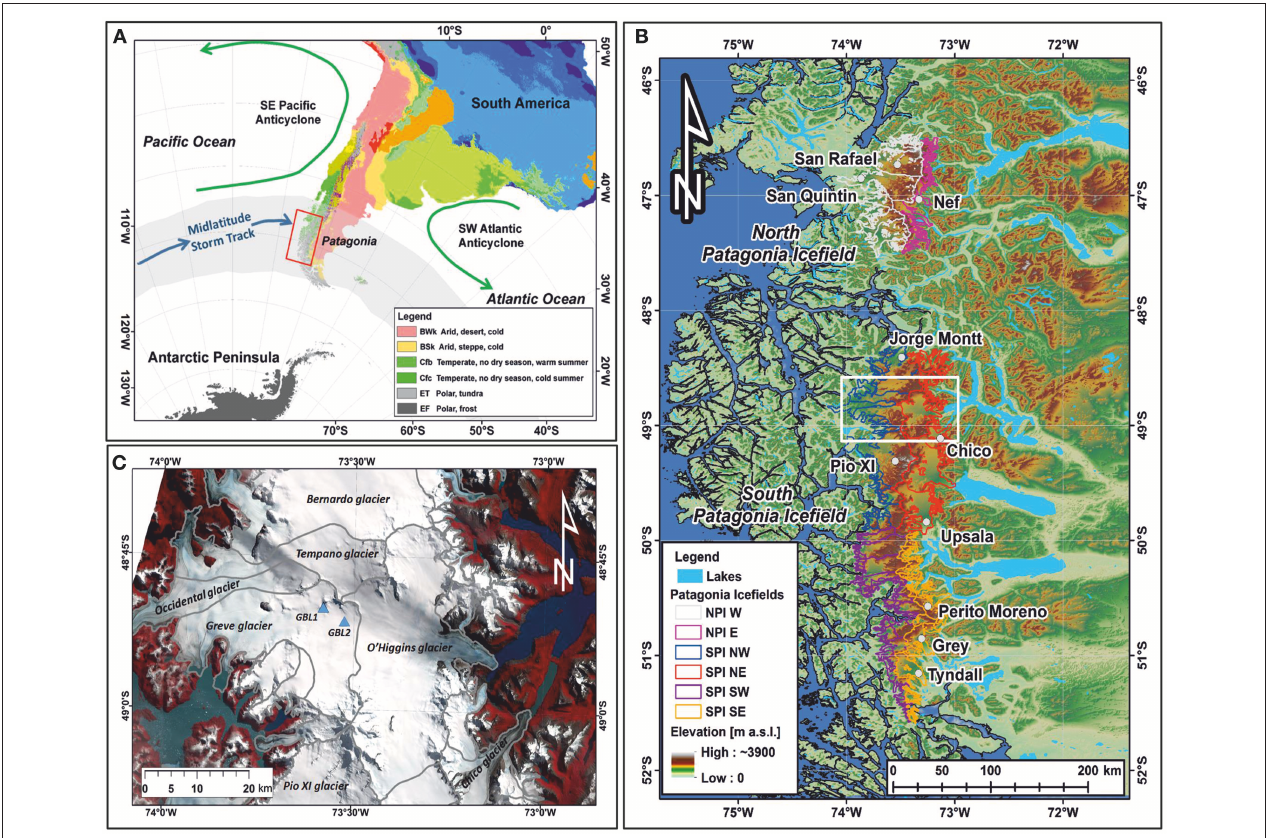
FIGURE 1 | (A) Regional climatic setting over the Patagonian region. Colors correspond to the predominant Köppen-Geiger climate classification for Patagonia (Beck et al., 2018 ) and the red rectangle corresponds to the study area. (B) SRTM topography at 1km resolution of the study area and locations of some glaciers mentioned in the text, and (C) localization of the observations (Ultrasonic Depth Gauges) used in this work. The satellite image was acquired by Landsat 8 (OLI) on the 8 April